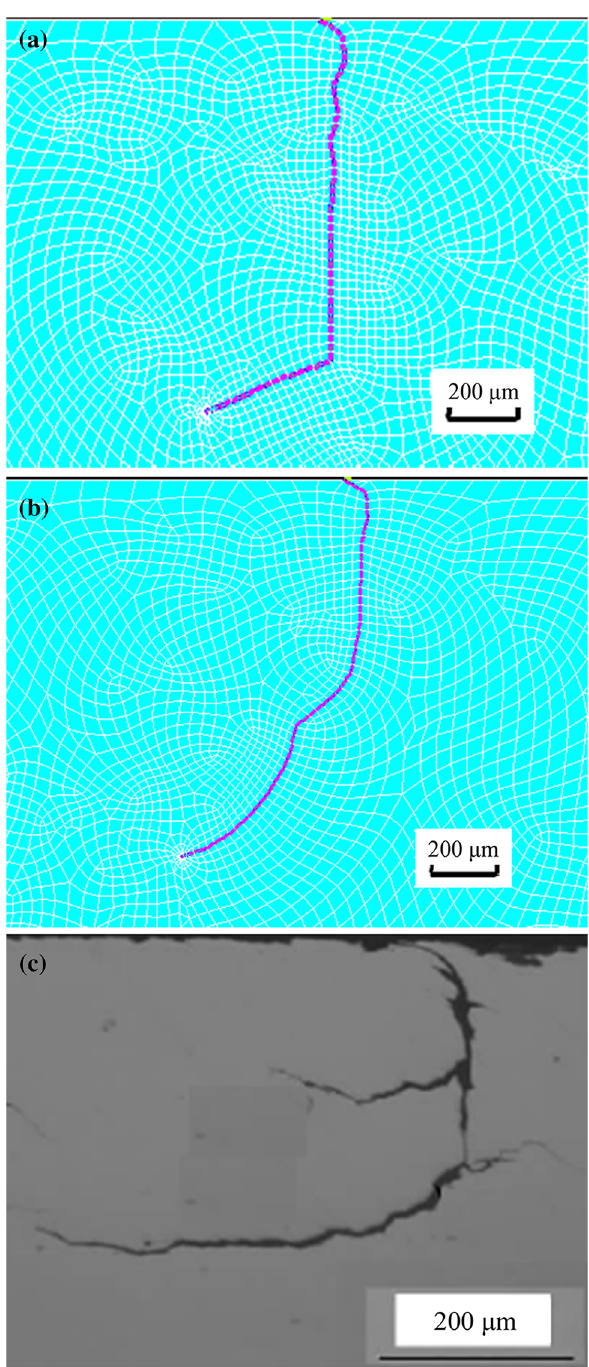
Fig. 7 Comparison of crack paths between simulation and experi- ment: a Simulated crack path for 50 km/h train. b Simulated crack path for 350 km/h train. c Experimental crack path in Datong– Qinhuangdao line rail